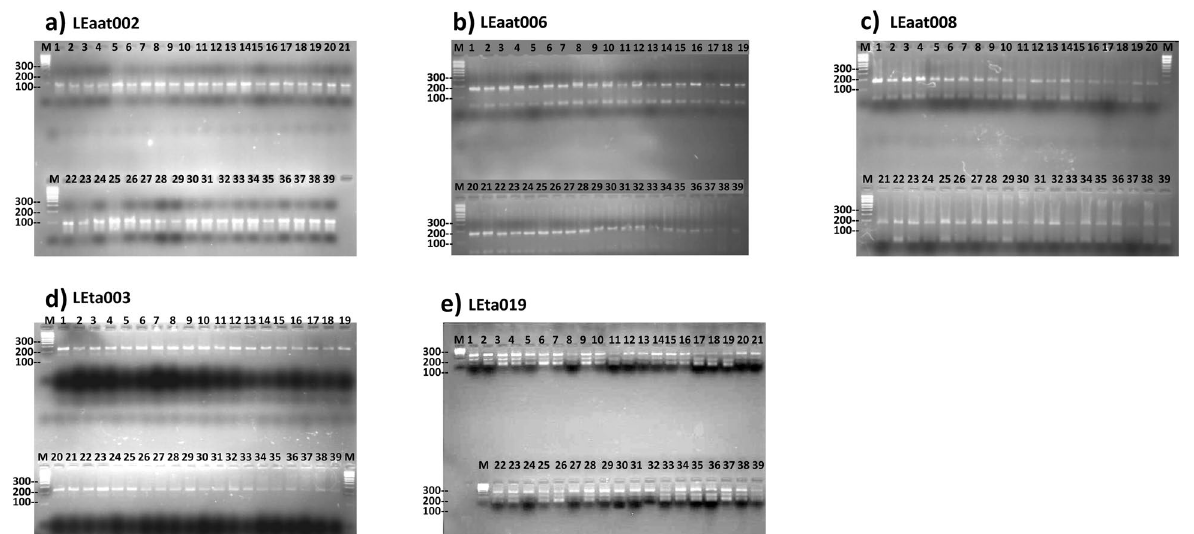
Fig. 3 SSR pattern using primer LEaat002 (expected size is 106 bp), LEaat006 (expected size is 174 bp), LEaat008 (expected size is 178 bp), LEga003 (expected size is 241 bp), and LEta019 (Expected size is 301 bp) for 39 tomato landraces. The numbers from 1 to 39 denote tomato landrace number. M molecular weight marker (100bp) =